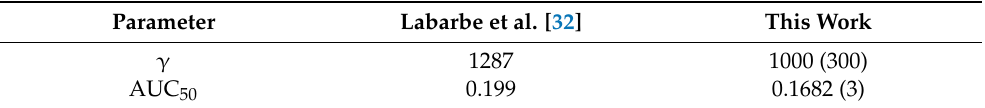
Table 2. Fitting parameters for Equation (8) and their respective errors, corresponding to the fits shown in Figure 10 (Section 4.3). Parameter Labarbe et al. [32] This Work γ 1287 1000 (300) AUC 50 0.199 0.1682 (3)